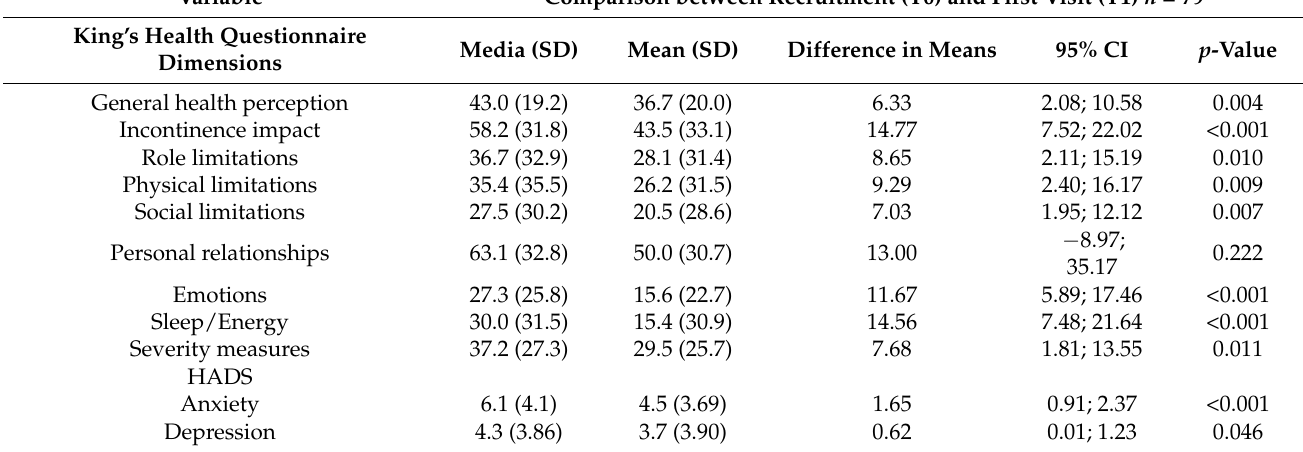
Table 8. Evolution of quality of life and mood during follow-up between T0 and